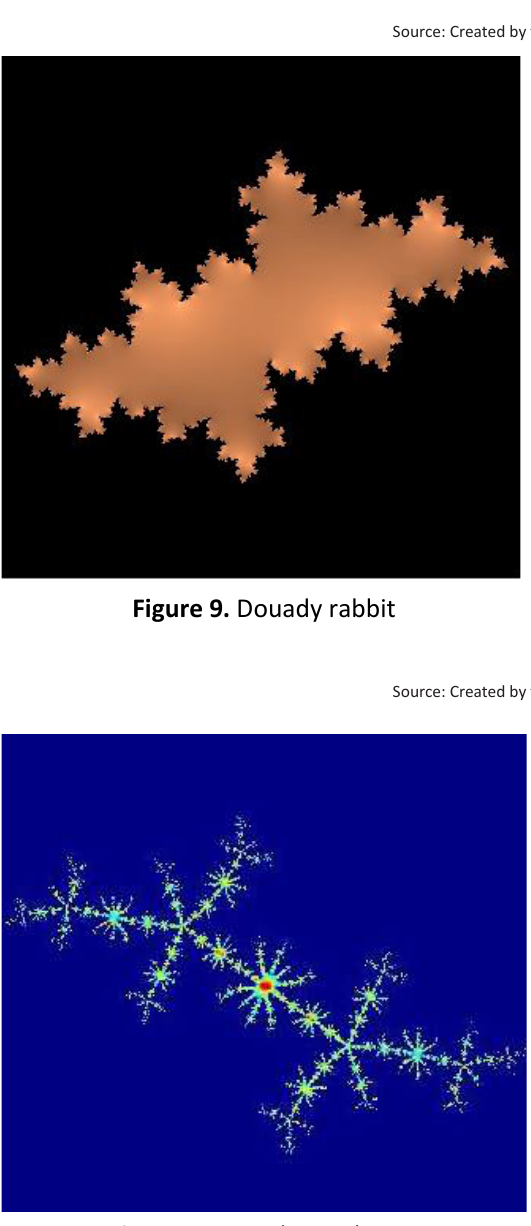
Figure 10. Dendrite Julia